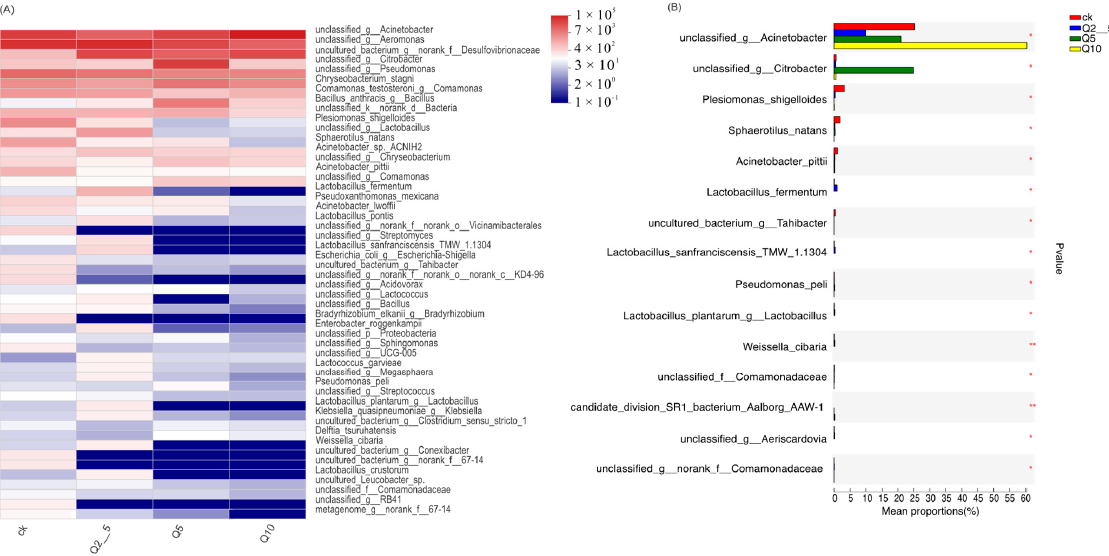
Figure 3. ( A ) Heat map of different species. Heat map showing differences at the genus and species levels. The horizontal direction is the sample information and the vertical is the annotation information for species. Red indicates a higher relative species abundance and blue indicates a lower relative species abundance. ( B ) Species exhibiting differences in abundance among the four groups. The Y -axis indicates the species name at a given taxonomic level and the X -axis indicates the mean relative abundance of the species among the different groupings. The different colored bars indicate different groupings. The value on the right is the p -value where p < 0.05 was considered statistically significant (* p < 0.05, ** p < 0.01). Samples were divided into four groups: CK, Q2_5, Q5, and